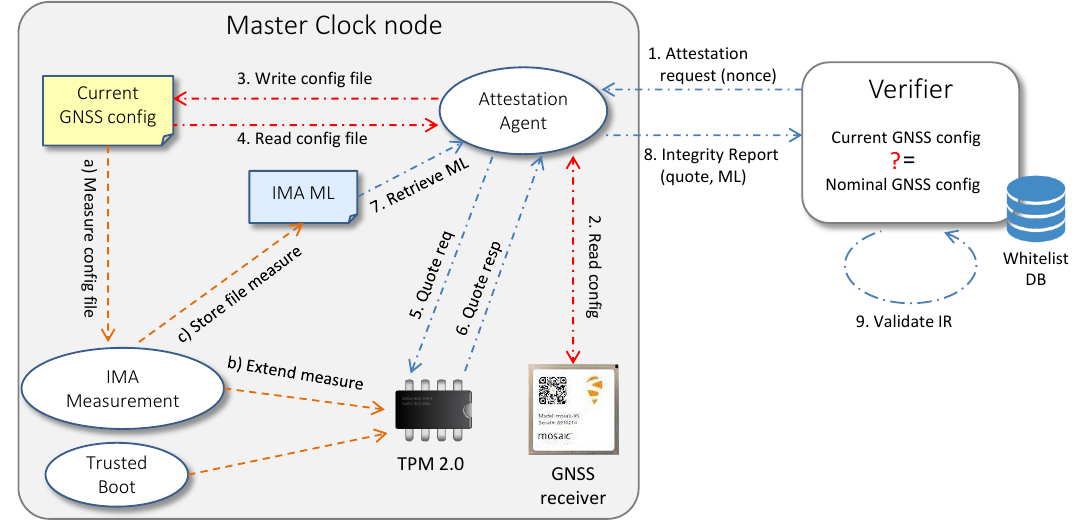
Figure 6. Workflow for remote attestation of a Master Clock node.